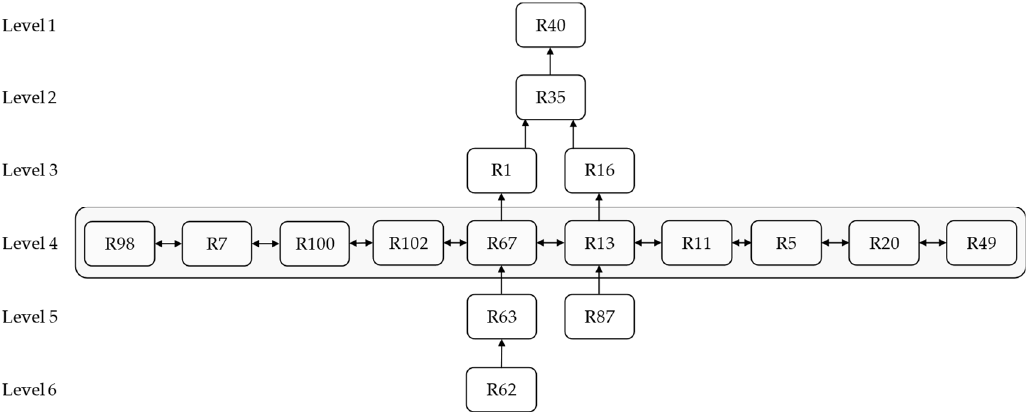
Figure 5. ISM-based model of BSC risks.